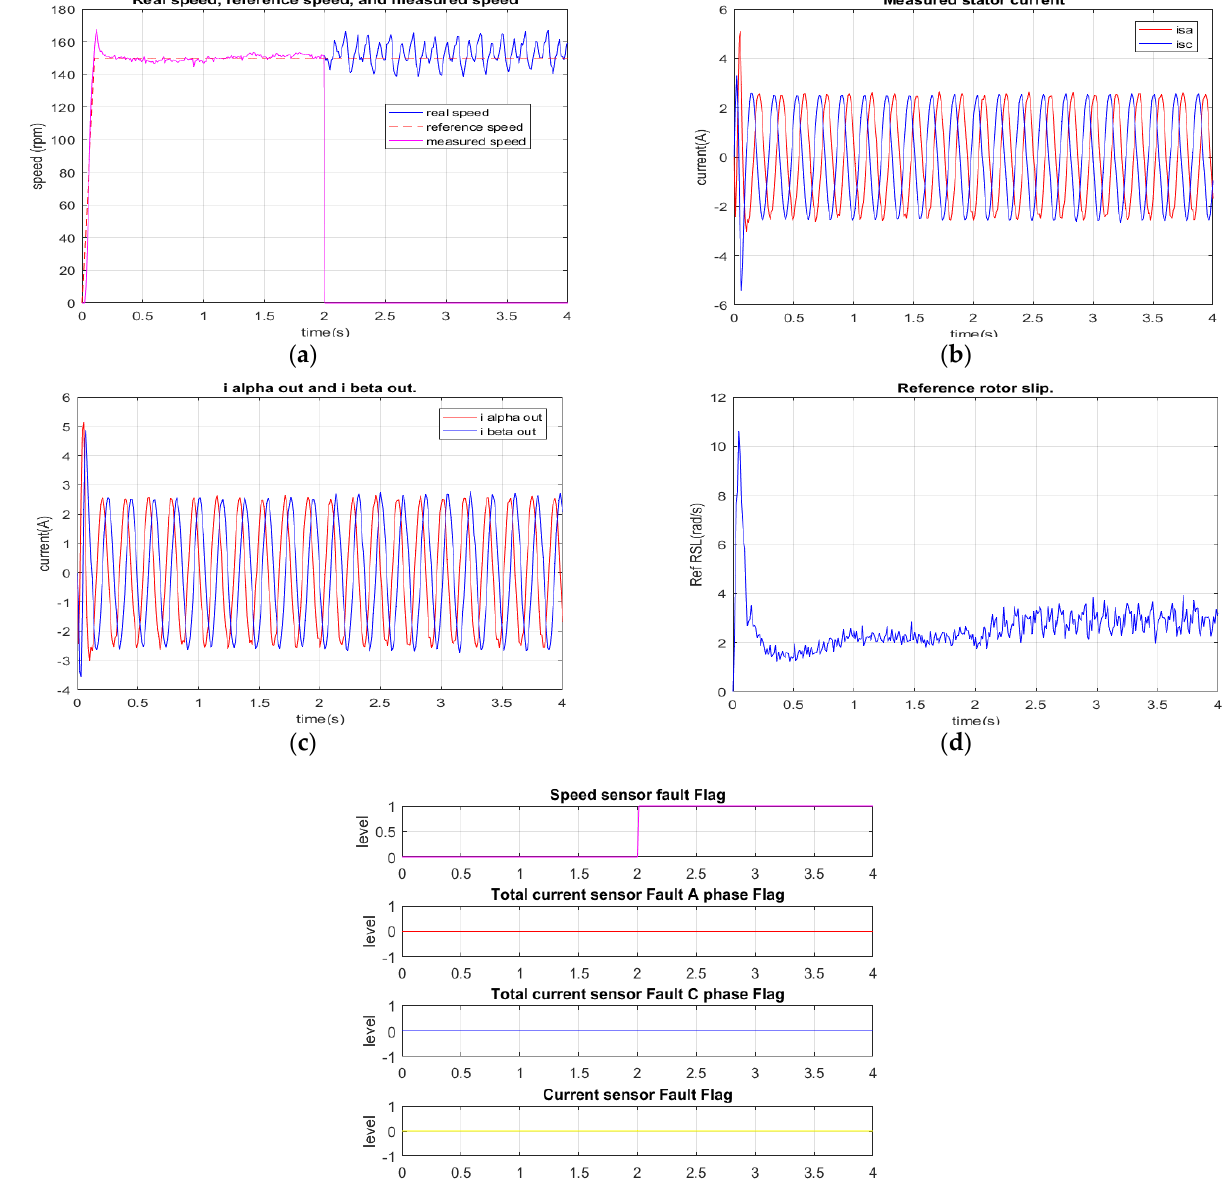
Figure 12. Experimental results: total rotor speed sensor failure at 2 s. ( a ) Reference, real, measured speeds; ( b ) measured current; ( c ) stator current vector components for FOC controllers (FTC outputs); ( d ) reference rotor slip; ( e ) sensor fault indications.